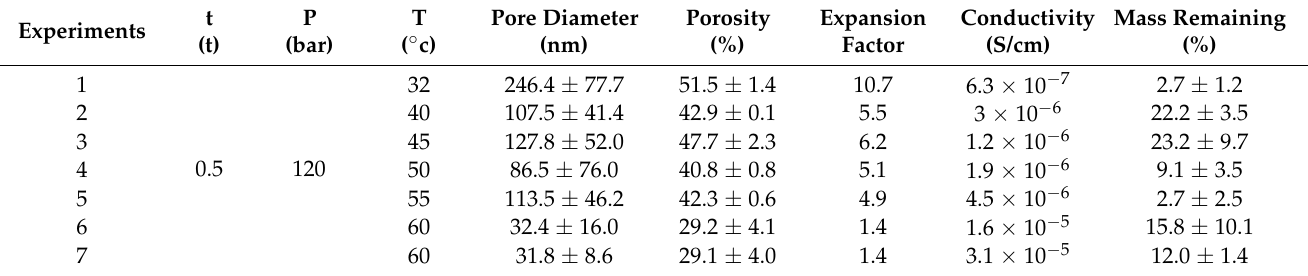
Table 1. Supercritical foaming experiments to evaluate the influence of temperature on the